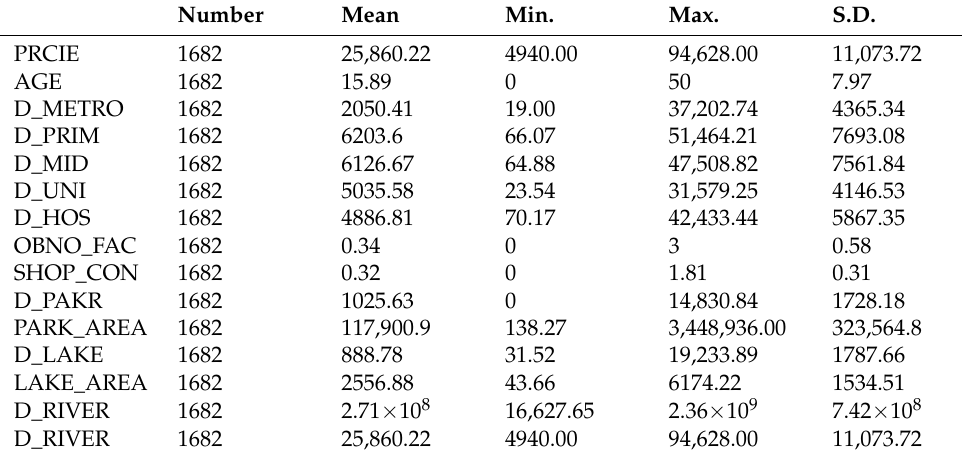
Table A6. Descriptive statistics of data in